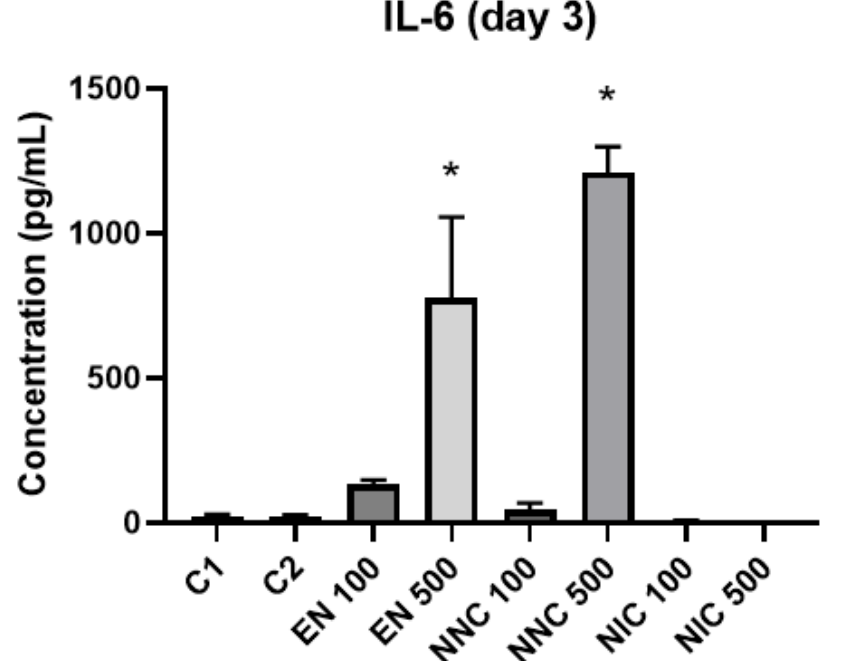
Figure 11. IL-6 detection three days after treatment with nanocapsules. C1 = control cells with no nanocapsule treatment and no LPS stimulus; C2 = control cells stimulated with LPS but no nanocapsule treatment. EN500 and NNC500 presented significantly higher levels of IL-6 compared to C1 (*: p < 0.05 samples vs. control).